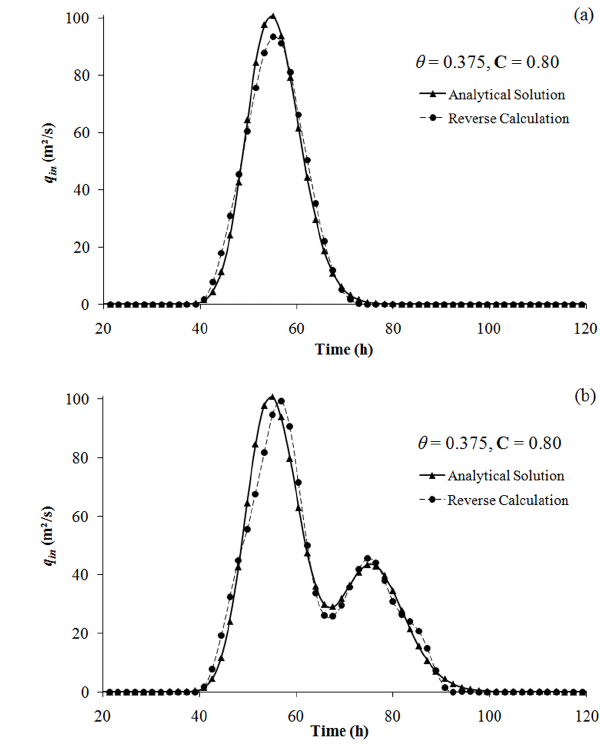
Fig. 8. Reverse routing with low-pass filtering (symmetric, second order, five-point Savitzky-Golay filter) of single-peak and double- peak imperfect outflow